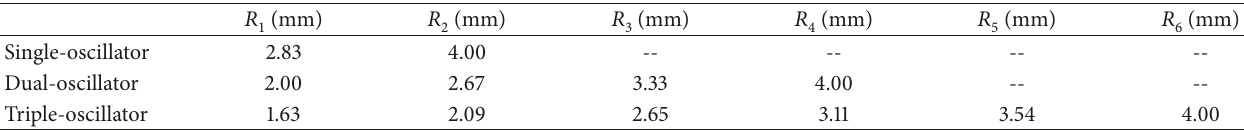
Table 1: Scatterer dimensions.